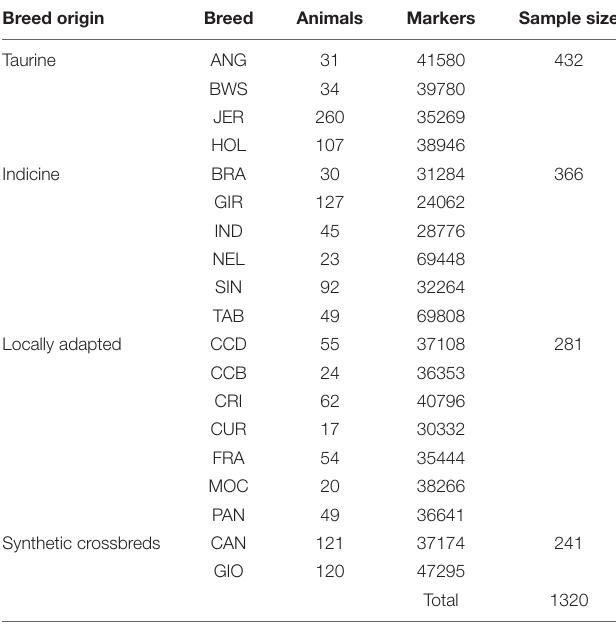
TABLE 1 | Number of animals by breed, number of SNPs after quality control, and number of animals by group in 19 cattle breeds raised in Brazil. Breed origin Breed Animals Markers Sample